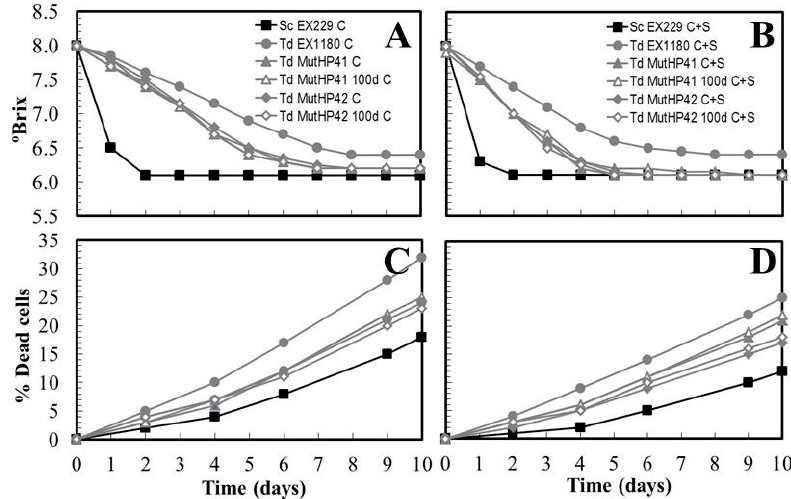
Figure 9. Genetic stability of HP R mutants. Fermentation kinetics of synthetic base wine supplemented with 30 mg / L SO 2 and inoculated with the mutants before and after 100 doublings (100d) on YEPD agar. Before inoculation, yeast cultures were conditioned with occasional shaking (C) or continuous shaking (C + S). Data are the mean values of three fermentations inoculated with each yeast strain. Standard deviations were less than 14% of the means. The degree of dominance throughout fermentation of each inoculated yeast strain was 100%. ( A , C ) Yeast cultures conditioned with occasional shaking. ( B , D ) Yeast cultures conditioned with continuous shaking.